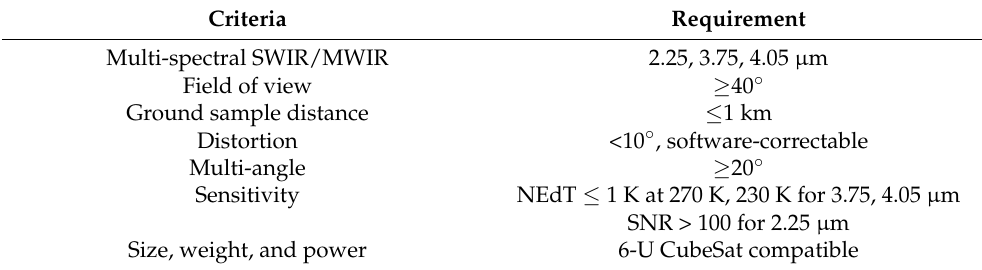
Table 3. Instrument